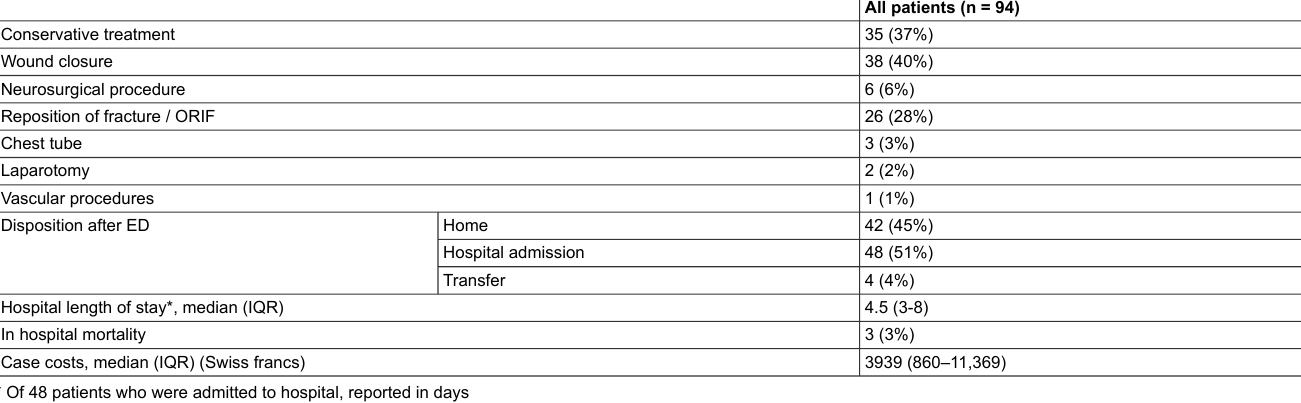
Table 3: Procedures performed, outcomes and case costs of patients admitted after cattle-related trauma. Conservative